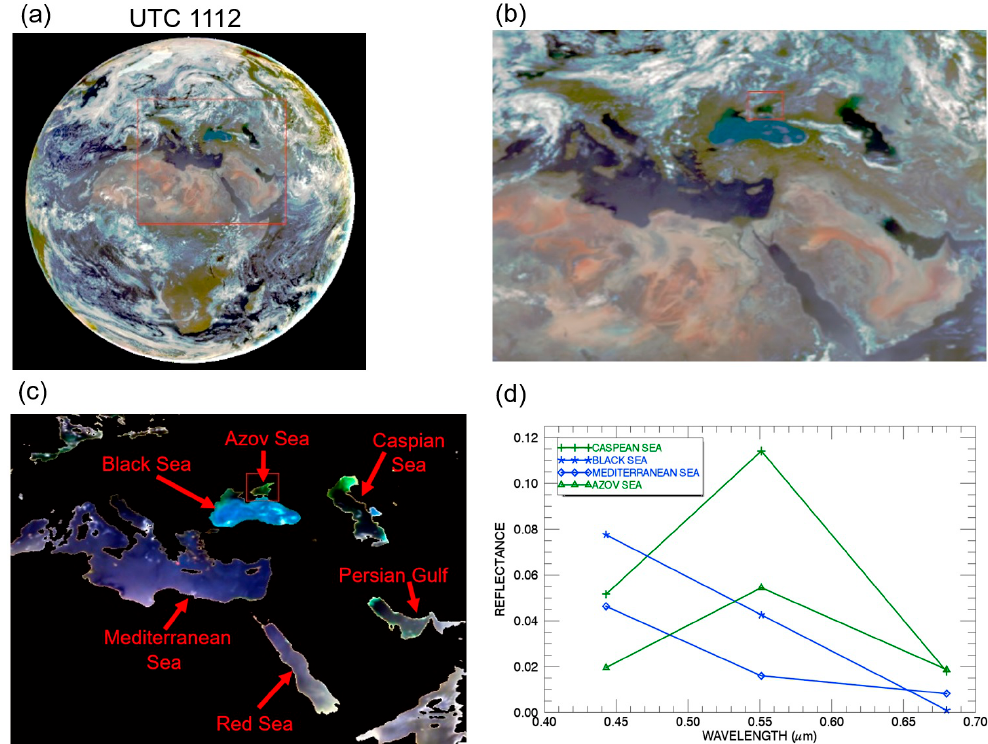
Figure 4. ( a ) The sunlit full disk color image processed from three atmosphere corrected EPIC channel (Red: 680 nm; Green: 551 nm; Blue: 443 nm) images acquired on 26 June 2017 at UTC 1112; ( b ) The portion of image over Caspian Sea, Black Sea, Azov Sea, Persian Gulf, Red Sea, and Mediterranean Sea; ( c ) The portion of image of water surfaces over the same area as that of ( b ), but after masking out the land and cloud pixels; ( d ) Spectral reflectances as a function of wavelength for two chlorophyll-rich water pixels (Green lines) over Caspian Sea and Azov Sea and two blue water pixels (Blue lines) over eastern portions of Black Sea and Mediterranean Sea.